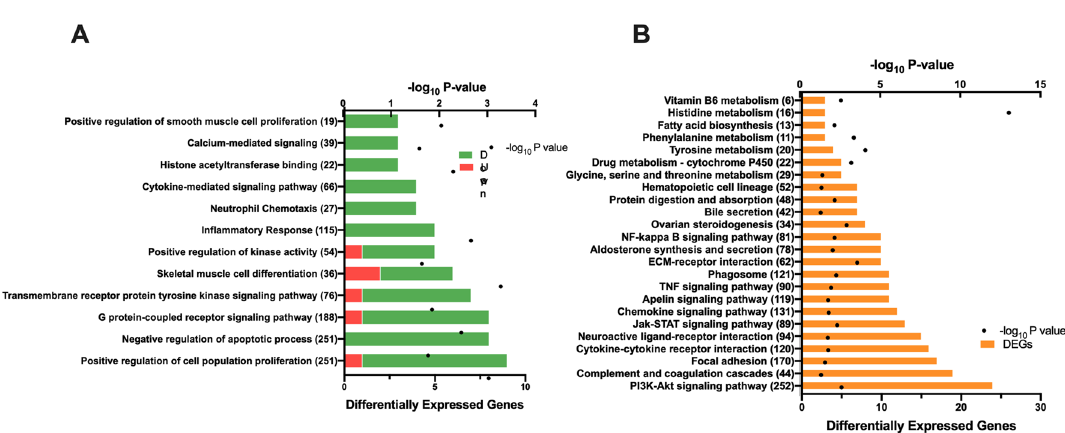
Figure 3. Significantly enriched ( A ) Gene Ontology (GO) and ( B ) Kyoto Encyclopedia of Genes and Genomes (KEGG) 25 pathways in the gluteus medius skeletal muscle tissue of pre-weaned dairy calves supplemented with 5-hydroxytrytophan (5-HTP, 90 mg/day; n = 4) or saline (CON, 8 mL saline; n = 4) for 10 consecutive days. The y-axis displays the names and total number of genes in each pathway/term, and the x-axis displays the number of differentially expressed genes (DEGs) within each pathway/term and the significance of enrichment (− log10 P-value). Red and green bars display the number of upregulated and downregulated DEGs in the 5-HTP group; orange bars display the number of